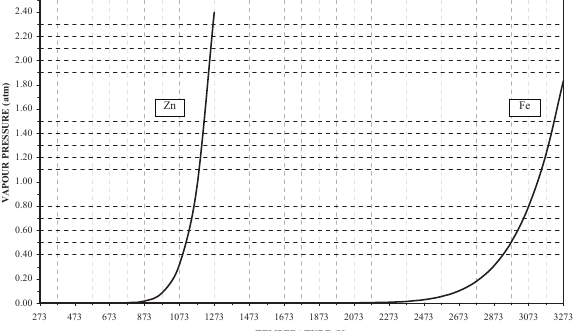
Figure 2. The partial pressure of metals over their liquid phase.